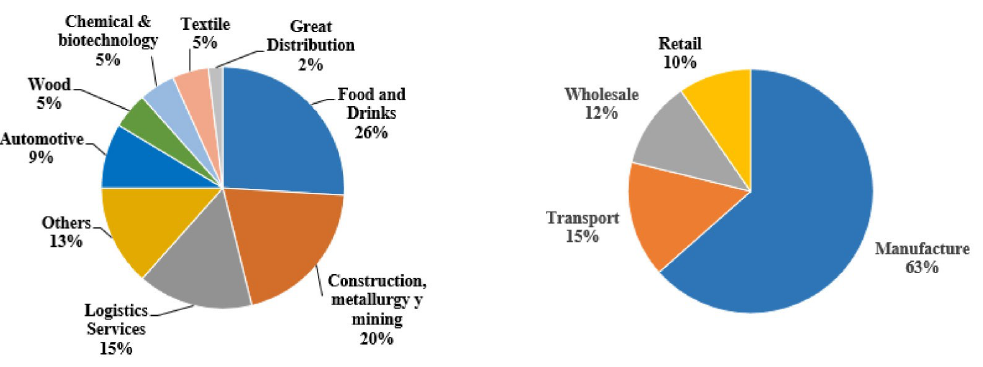
Figure 1. Companies by main sector and role in the supply chain